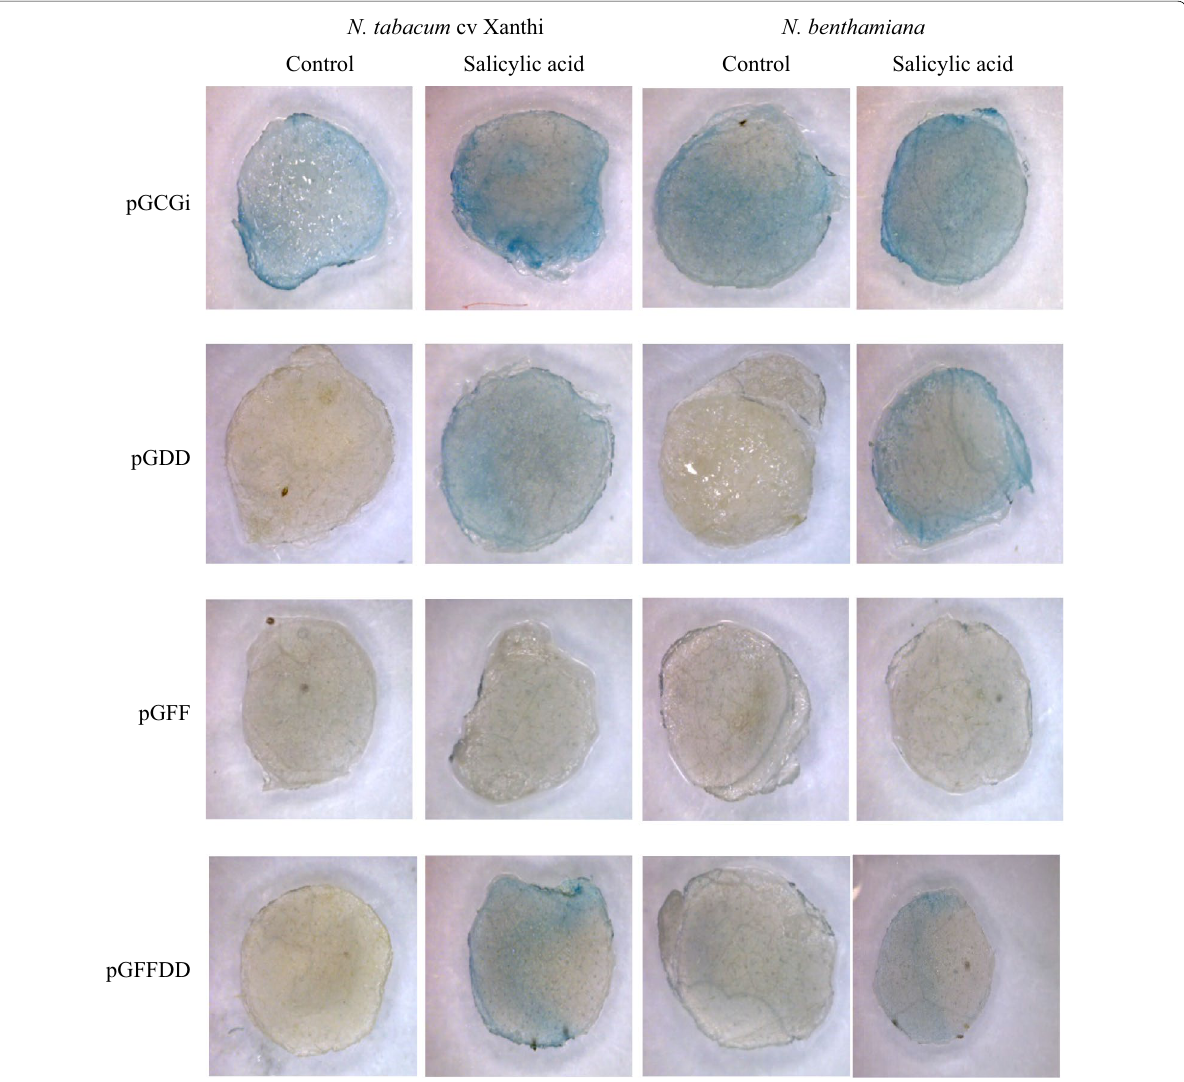
Fig. 4 Effects of salicylic acid treatment on pGCGi, pGDD, pGFF and pGFFDD constructs evaluated on two tobacco species; N. tabacum cv. Xanthi and N. benthamiana . Agro-injected plants without salicylic acid treatment were used as control (More replications have been presented in Additional file 1: Fig. S1 attached to the